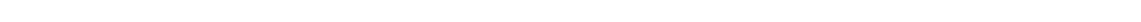
Fig. 7 Interfering with retrograde traf fi cking or Golgi/TGN organization impairs cAMP/PKA signaling and CREB phosphorylation. a Sequential HILO images showing effect of BFA on TGN organization and TSH/TSHR retrograde traf fi cking. Primary mouse thyroid cells were transfected with the TGN maker ST- RFP. Thereafter, they were treated with BFA for 30 min, stimulated with TSH-647 for 10 min and imaged for additional 30 min. b Immuno fl uorescence against RII β and either GOLPH4 (left) or TGN46 (right) in cells pretreated with BFA, showing displacement of the PKA RII β subunit from the Golgi and its reduced association with the TGN, respectively. Images were acquired by confocal microscopy. Data in a and b are representative of 3 independent experiments. c cAMP FRET responses (mean ± s.e.m.; n = 9/13) in primary thyroid cells isolated from Epac1-camps mice pretreated with or without (control) BFA for 30 min. d PKA FRET responses (mean ± s.e.m.; n = 11/11) in primary thyroid cells transfected with the AKAR2 sensor and pretreated with or without (control) BFA. Data in c and d were normalized as in Fig. 5. Differences at individual time points were compared using the Holm – Š ídák test for multiple comparisons (black dots, P values). e Western blot analysis of CREB (Ser133) phosphorylation in primary thyroid cells stimulated with TSH with/ without BFA pretreatment. α -tubulin was used as loading control. Images are representative of 3 independent experiments. Data (mean ± s.e.m., n = 3) are expressed relative to those measured in the mock-stimulated control sample. f Western blot analysis of CREB (Ser133) phosphorylation in primary thyroid cells transfected with Vps35 siRNA pool or control non-targeting siRNA and stimulated with TSH for 10 min. α -tubulin was used as loading control. Images are representative of six independent experiments. Data (mean ± s.e.m., n = 6) are expressed relative to those measured in the mock-stimulated control sample. Differences in e and f are statistically signi fi cant by two-way ANOVA. * P < 0.05 by Bonferroni ’ s post hoc test. g Schematic view of the results